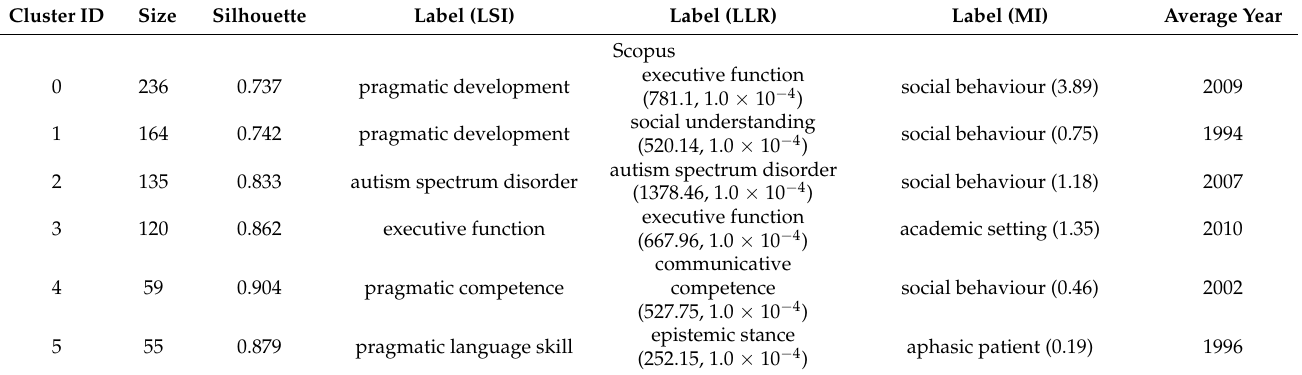
Table 6. Summary of the largest clusters of pragmatic language